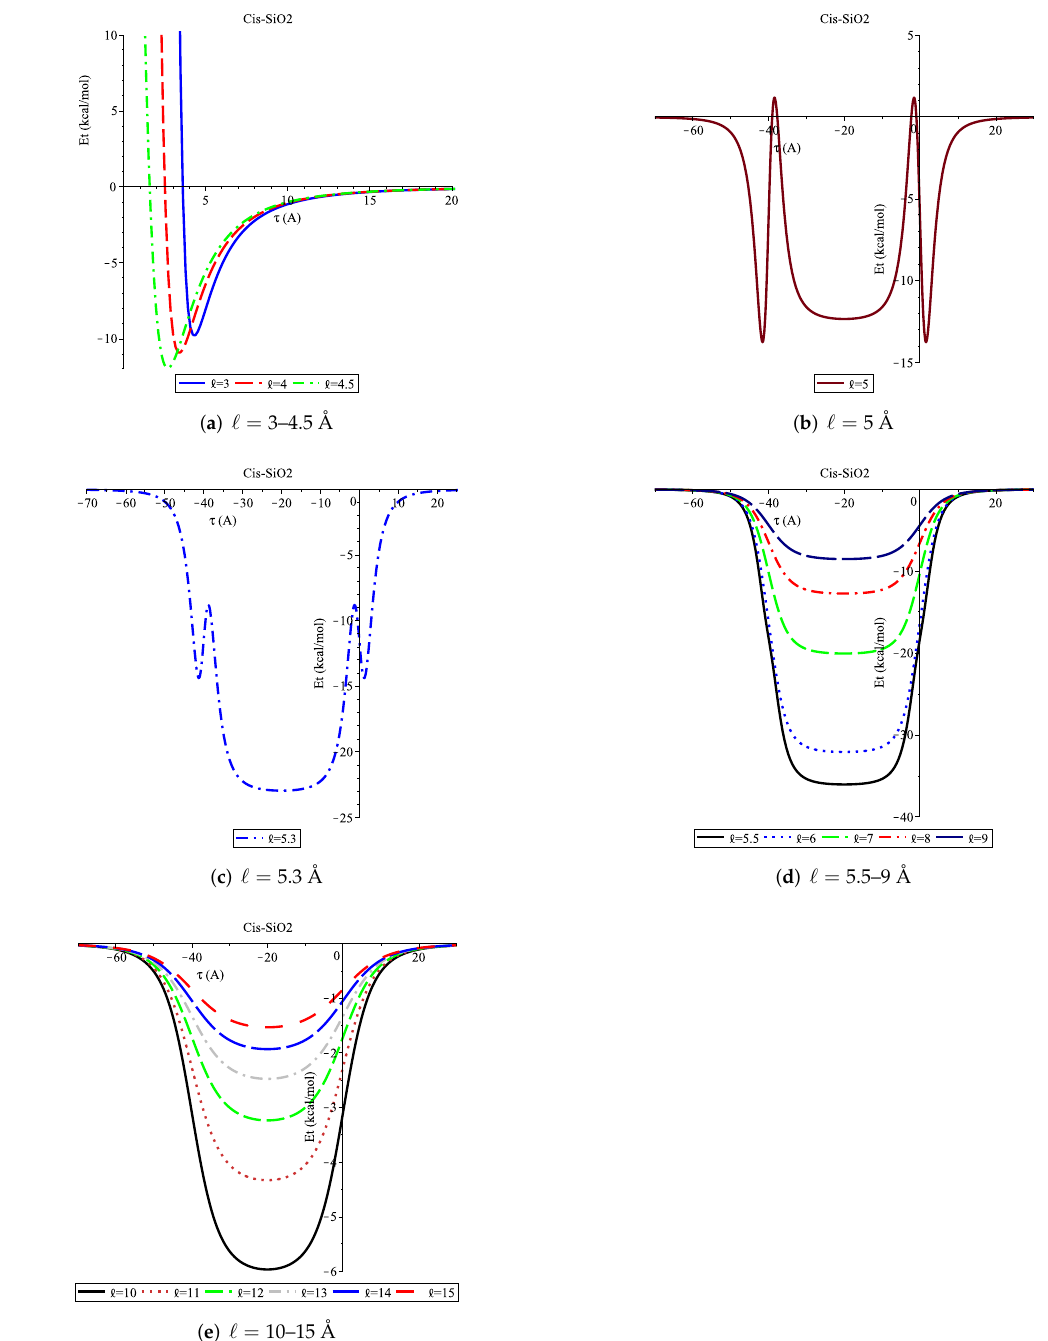
Figure 3. Energies of Cis molecule and SiO 2 nanopore of different radii (cid:96) with respect to the distance τ